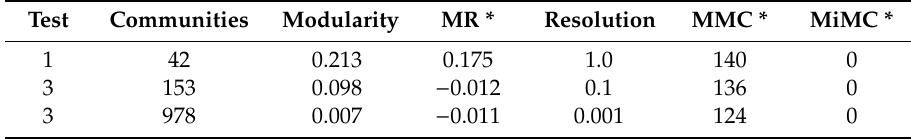
Table 4. Modularity report (MR) communities’ measurements.